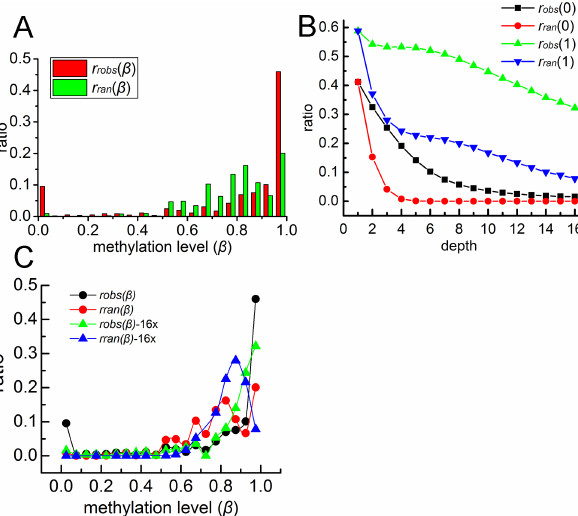
Fig 1. The bimodal distribution of CpG methylation in human brain samples. (A) The bimodalbias caused by the inhomogeneity of sequencing depth in humanbrain cells (chromosome 1 of the 12yr sample). (B) The observed ratio and the random ratio of 0 and 1 end of the methylationlevel distribution in different sequencing depths. (C) The observedand randommethylationlevel distribution of all sequencing depth (black circle and red circle respectively)and the observedand random methylation level distributionunder the sequencing depth of 16x is in green triangleand blue trianglerespectively.